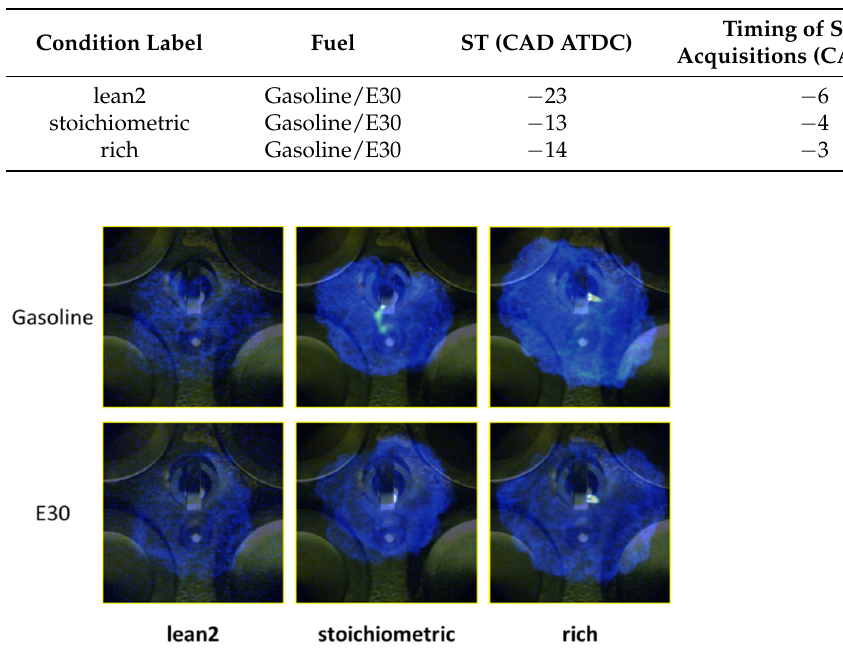
Figure A2. Flame images representative of the timing of spectra acquisition at the CADs reported in Table A1.